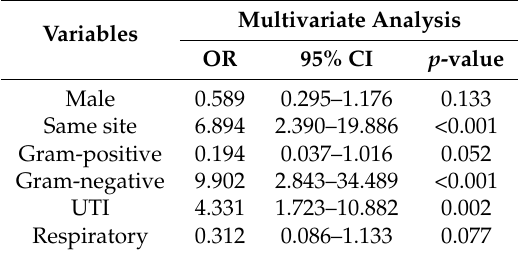
Table 4. Multivariate Analysis for Same Organism Reinfection in Study